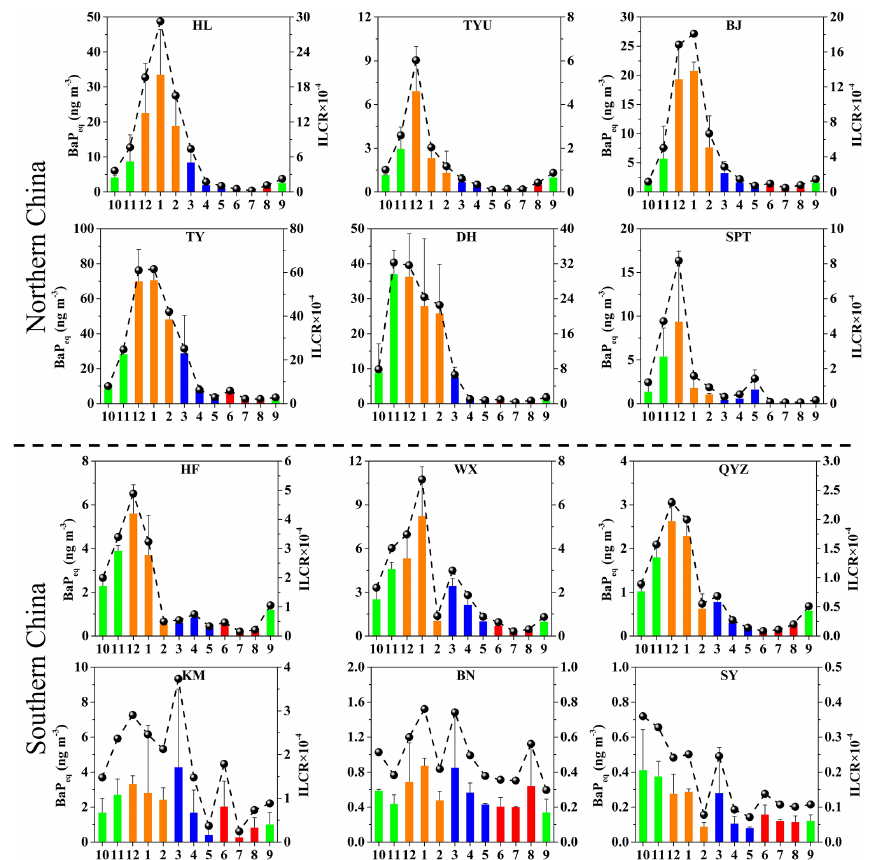
Figure 8. Monthly variations of BaP eq and ILCR at sites in northern China and southern China. The green, yellow, blue and red bars represent BaP eq in fall (October–November 2012 and September 2013), winter (December 2012–February 2013), spring (March–May 2013) and summer (June–August 2013),